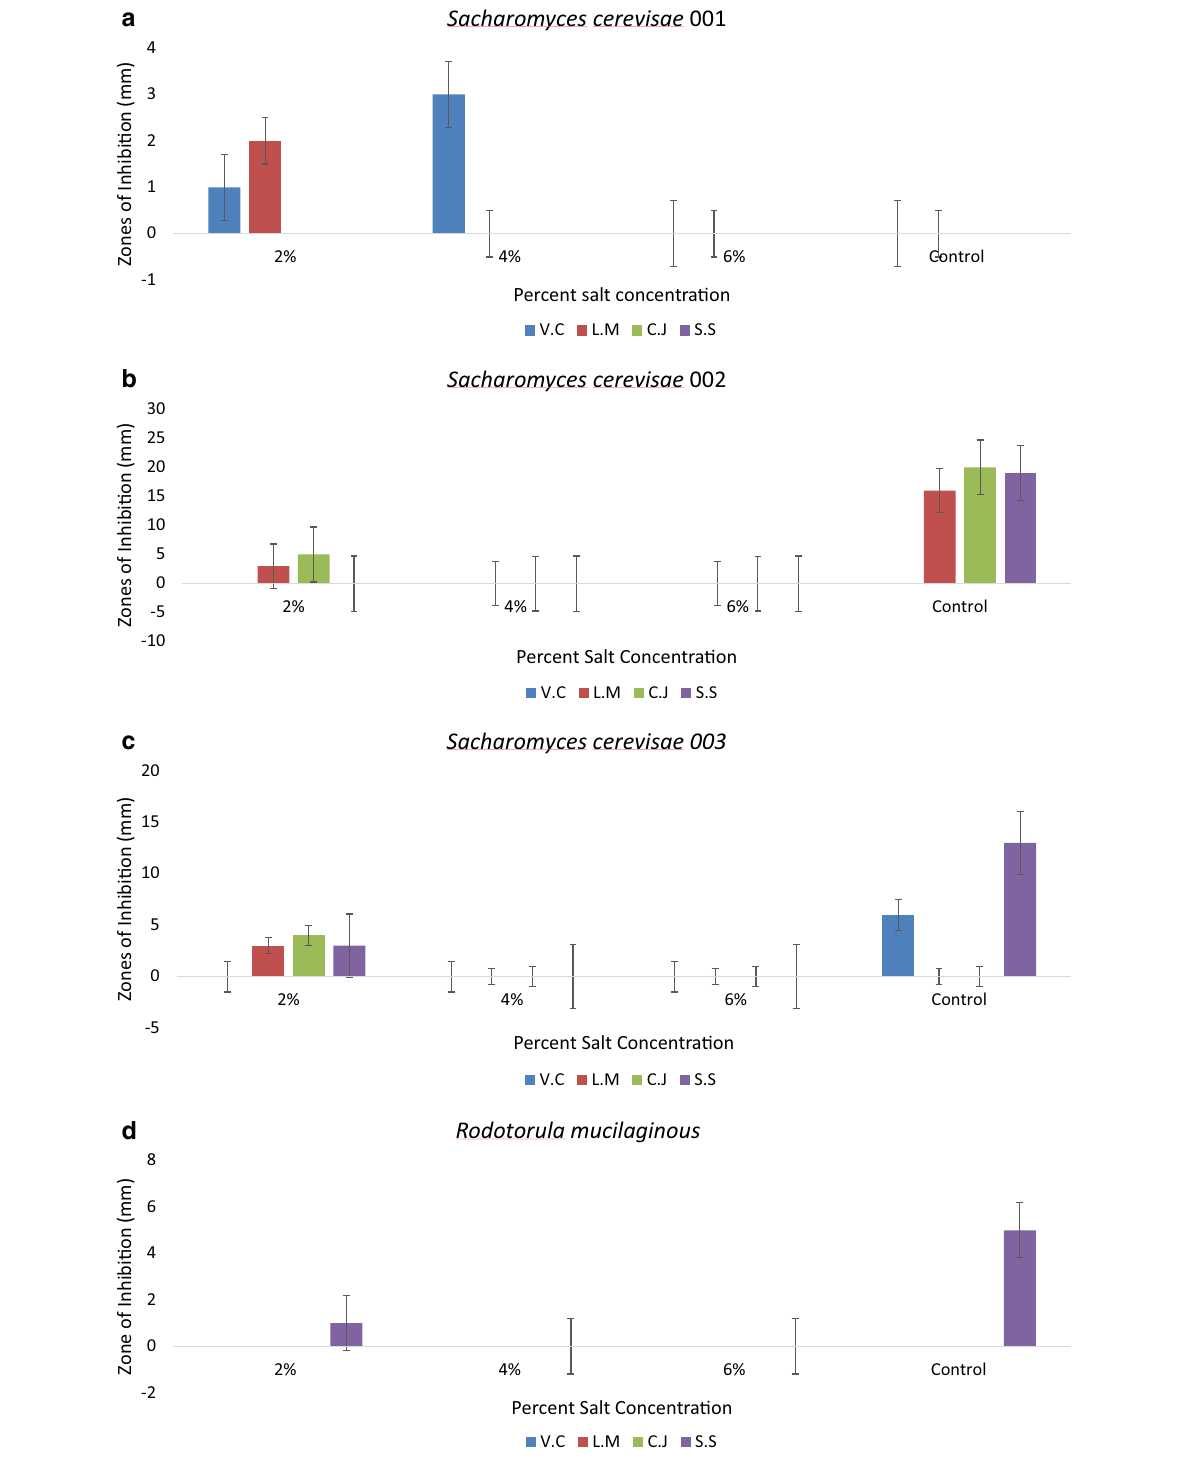
Fig. 4 a Effect of salt concentration on the antimicrobial activity of Saccharomyces cerevisiae. b Effect of salt concentration on the antimicrobial activity of Saccharomyces cerevisiae 002. c Effect of salt concentration on the antimicrobial activity of Saccharomyces cerevisiae 00. d Effect of salt concentration on the antimicrobial activity of Rhodotorula mucilaginosa. e Effect of salt concentration on the antimicrobial activity of Rhodotorula